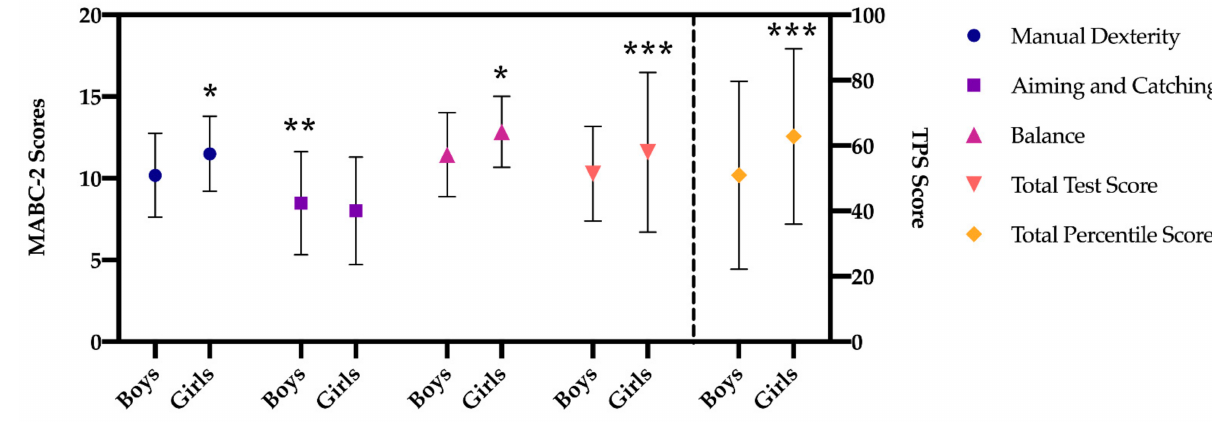
Figure 2. Differences in MABC-2 scores between boys and girls of the total sample. Note: scores (range: 1–19); TPS score (range: 0.01–99.9); * p < 0.001; ** p < 0.05; *** p <